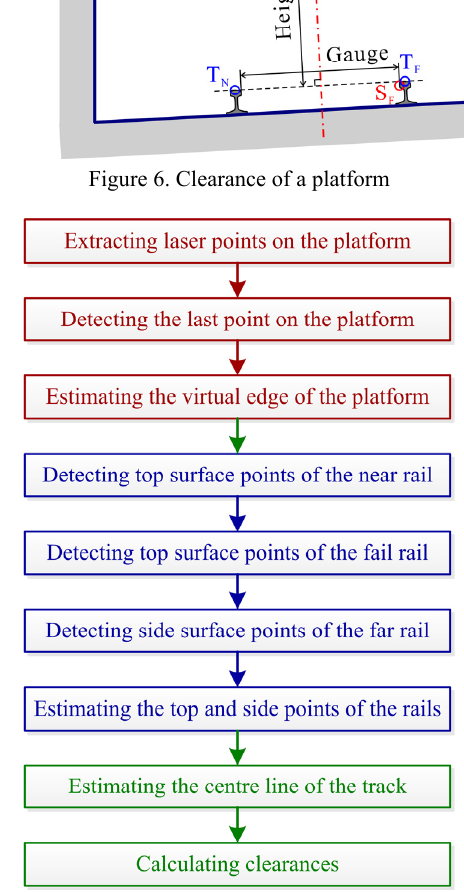
Figure 5. Measurement process by our new system